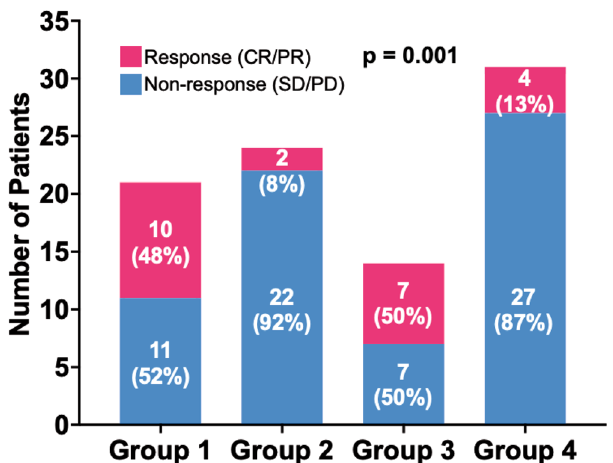
Fig. 4 The molecular subtypes are associated with response to immune checkpoint inhibitors. Patients with advanced gastric cancer who were treated with immune checkpoint blockade were strati fi ed by molecular subtypes. Response is de fi ned by complete response (CR) or partial response (PR). Non-response is de fi ned as stable disease (SD) or progressive disease (PD). The chi-square test was used to compare groups. Source data are provided as a source data fi